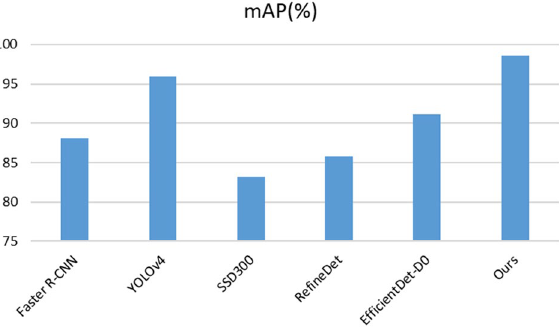
Figure 9. Comparison of accuracy with other advanced